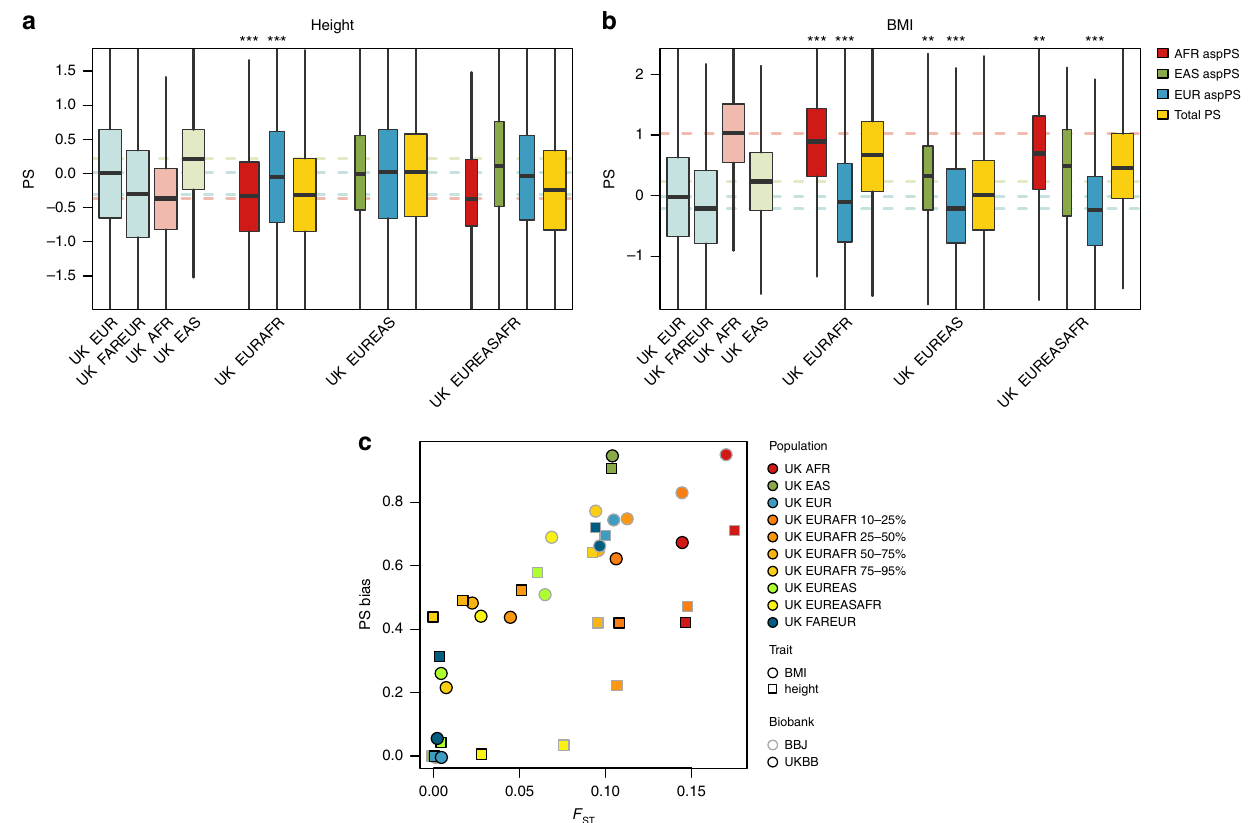
Fig. 4 Population-wide PS and aspPS in UKBB admixed individuals. PS distributions for four reference populations (pastel colors), three admixed populations (yellow) and their relative ancestry speci fi c partial PS (red, blue, green). Reference population medians are represented with dashed lines. The width of the boxplots is proportional to the median size of the ancestry fraction used to compute each aspPS. Two different PS are shown: ( a ) height 29 and ( d ) BMI 29 . Signi fi cant differences with randomly assigned ancestral components are encoded as: *: p ≤ 0.05, **: p ≤ 0.005, ***: p ≤ 10 − 5 (one-sided Wilcoxon signed-rank test). Sample sizes and exact P-values are reported in Supplementary Data 1. For each distribution, the box represent the interquartile range (IQR = Q 3 − Q 1 ), the line across the box indicate the median, the whiskers extend to the most extreme data points within Q 1 − 1.5IQR and Q + 1.5IQR, outliers are omitted. ( c ) PS bias, de fi ned as mean PS difference not explained by trait difference, is compared with F 3 population. All populations extracted from UKBB are represented, showing for UK EURAFR the fraction of European ancestry, UK EUR is the reference population for UKBB-based PSs, while UK EAS is the reference for BBJ-based PSs. EUR indicates european descent, EAS east asian descent, AFR african descent; combinations indicate admixed samples. FAREUR indicates Europeans far from the UKBB